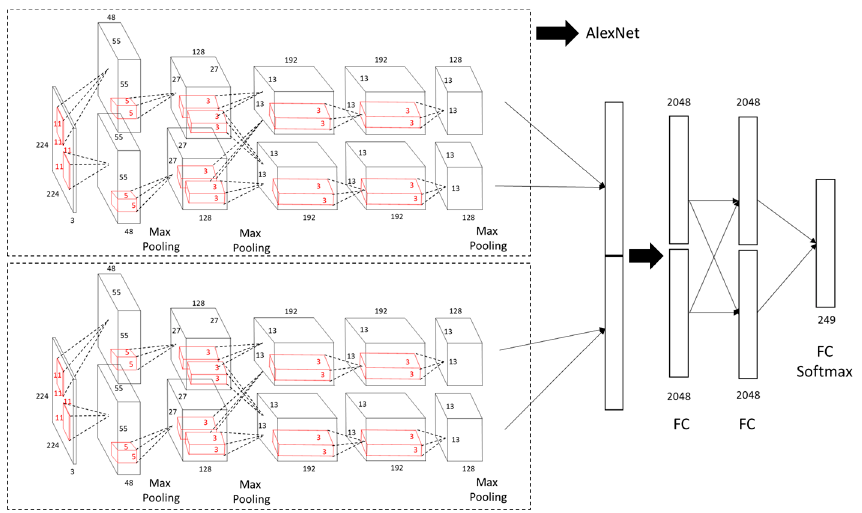
Figure 1. Structure of a dual-input convolutional neural network.